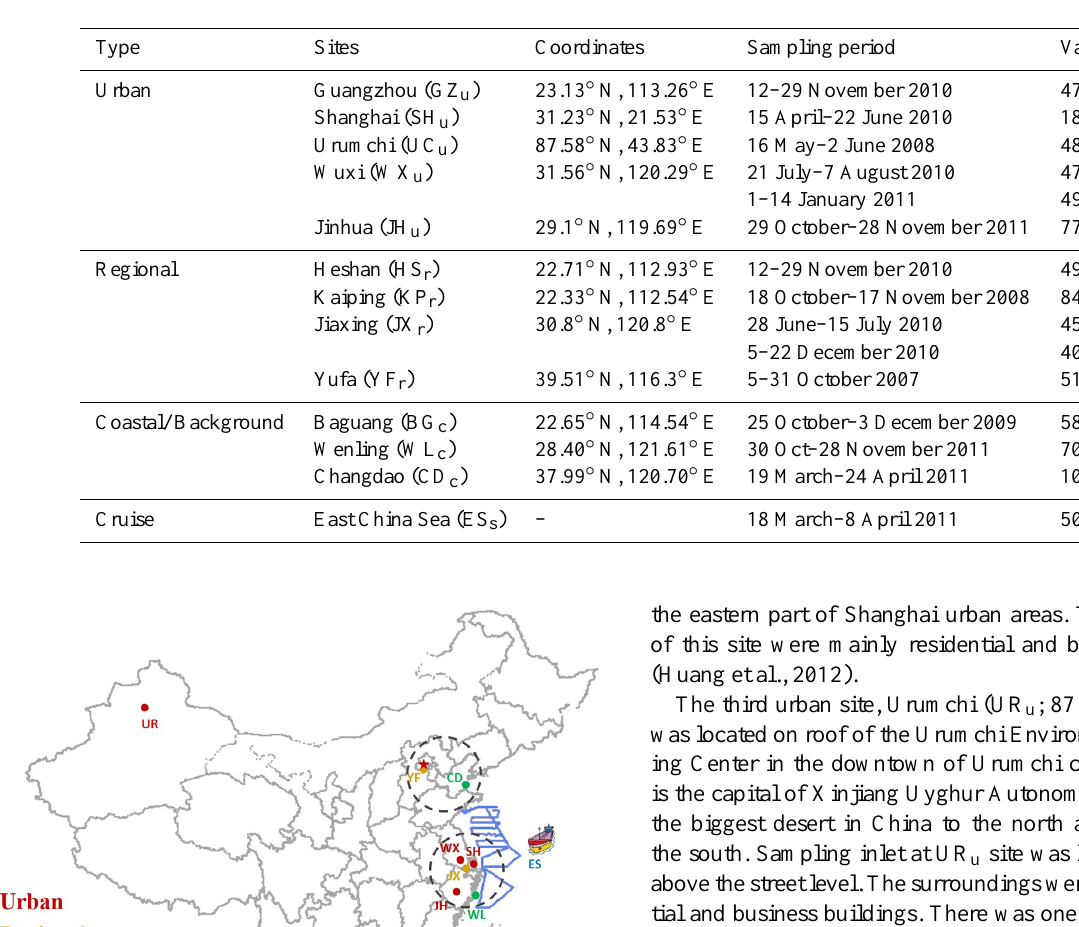
Table 1. Summary of information providing description of sampling periods at each measurement site. Please note that the words in paren- thesis against each site represent a short name of each site, and subscripts u, r, c and s indicate urban, regional, background/coastal and cruise site types, respectively.